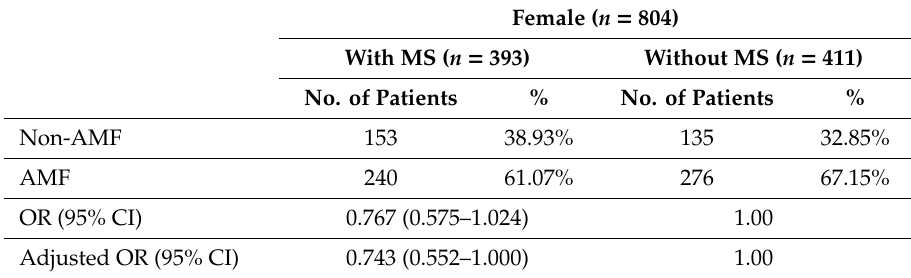
Table 3. Odds ratio for females with a diagnosis of multiple sclerosis with amalgam fillings. Female ( n = 804)